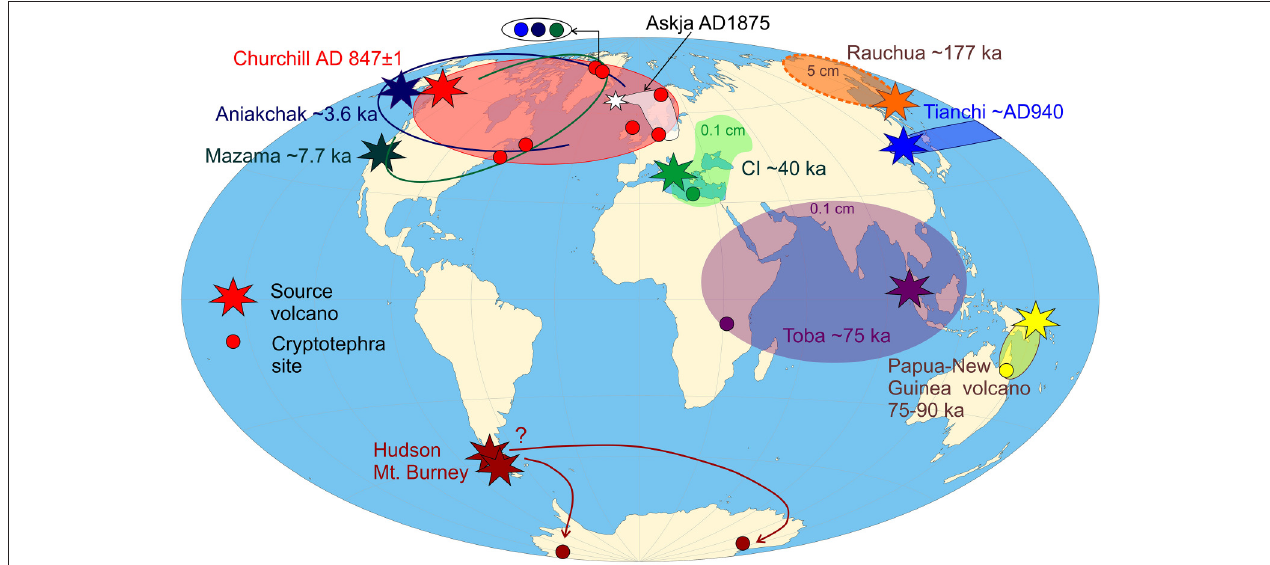
FIGURE 2 | Sketch map illustrating selected intercontinental and ultra-distal correlations of tephra discussed in the text. Tephra dispersal footprints are based on recent cryptotephra findings, and on modeling based on measured thickness of visible tephra layers. An equal area projection ensures visual comparison of the dispersal areas. Probable extent of ash plumes based on cryptotephra findings: Churchill (White River ash), Aniakchak, Mazama, a tephra from Papua-New Guinea (Zdanowicz et al., 1999; Coulter et al., 2009, 2012; Jensen et al., 2014). Ash plumes based on modeling results: Toba and Campanian Ignimbrite (CI); outer rim at 0.1cm ( Costa et al., 2012, 2014). Filled circles show selected cryptotephra sites. Tianchi tephra has been found in Greenland ice along with Aniakchak, Churchill and Mazama ones (color circles in and above Greenland; Sun et al., 2014), however, ultra-distal pathway for the Tianchi plume is not constrained. Suggested correlations of some cryptotephras found in the Antarctic ice cores to South American volcanoes (probably Mt. Burney and Hudson) based on Kurbatov et al. (2006) and Narcisi et al. (2012). Well mapped Askja 1875 plume is provided for comparison (Carey et al., 2010). The Rauchua tephra (Kamchatka) 5-cm outline (Ponomareva et al., 2013a ). The Rauchua tephra as well as many others mapped only as visible layers in fact may extend well beyond known